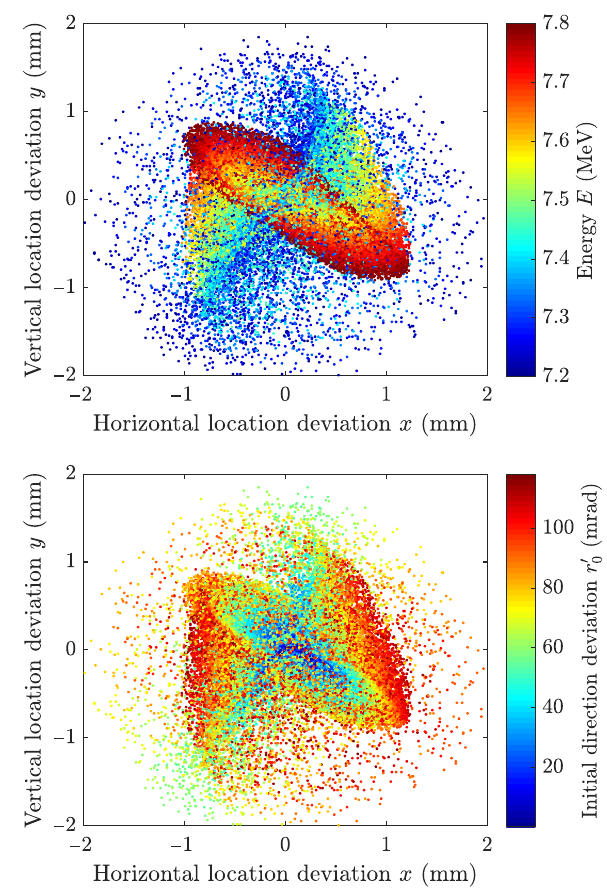
FIG. 5. The positions of the various protons are shown at the end of the beamline and their energy (upper picture) or their initial direction deviation (lower picture) are indicated by the